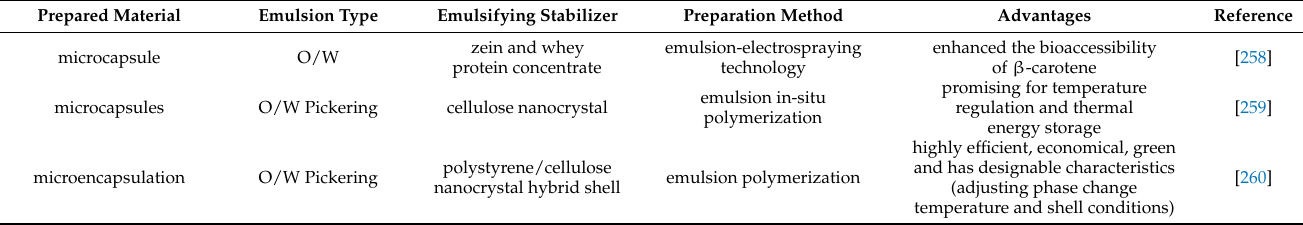
Table 2. Applications of food-grade emulsions in material